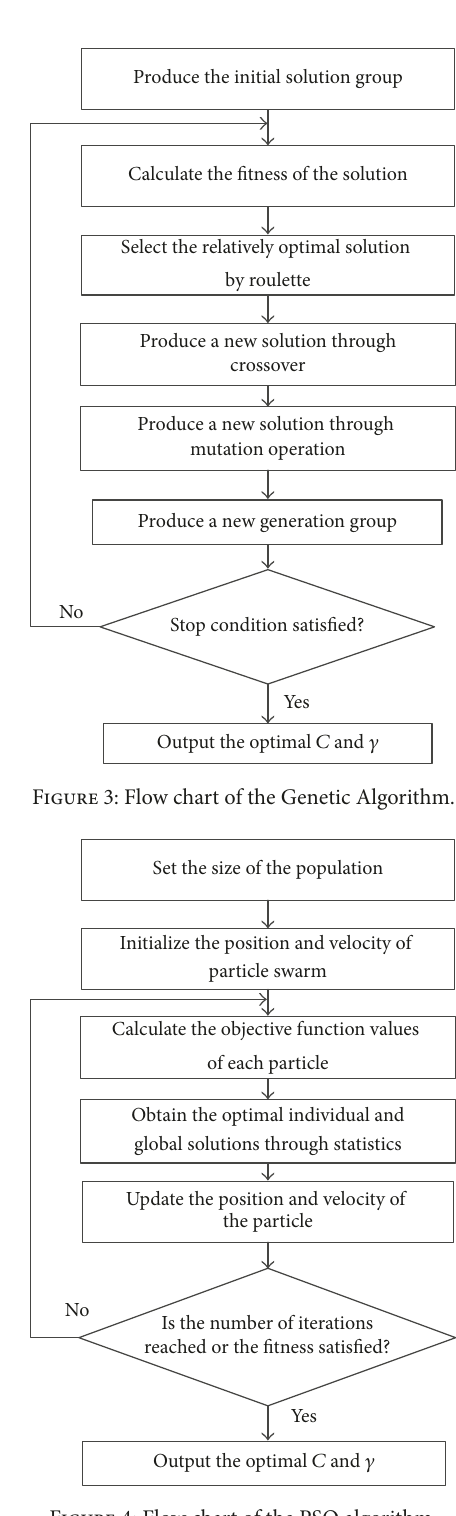
Figure 4: Flow chart of the PSO algorithm. above accuracies [40]. The cross-validation accuracy 𝑒 𝑛 is shown